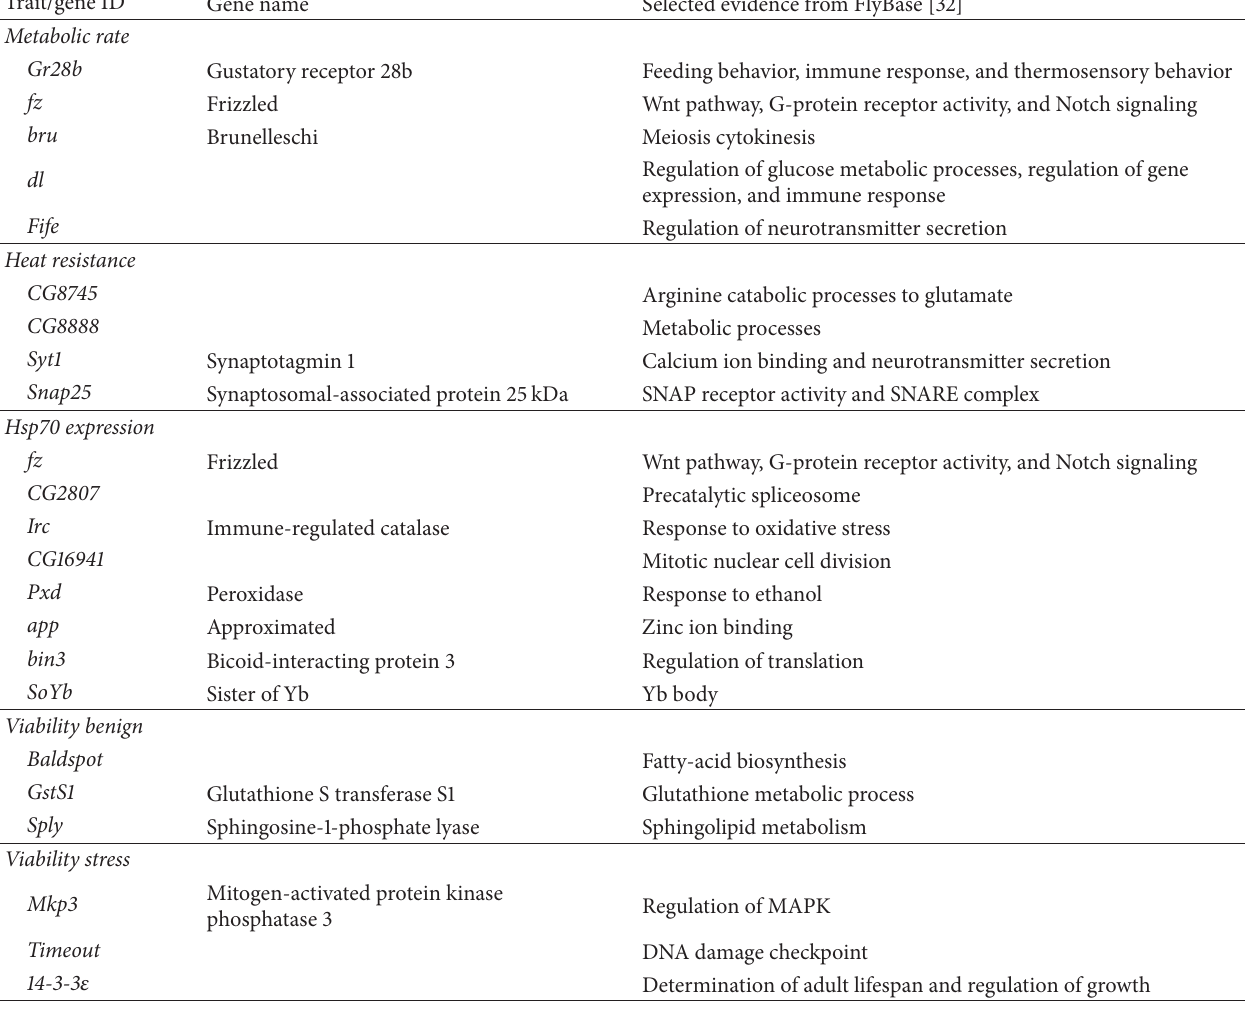
Table 5: Genes within associated GOs that explain > 20% of the genetic variation within